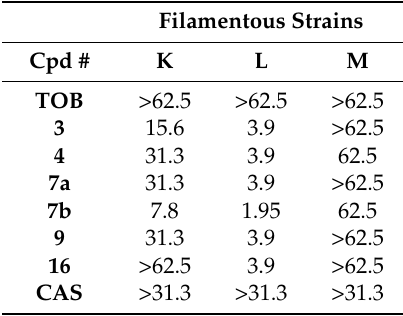
Table 3. The MIC values a (in µ g/mL) determined for TOB; its derivatives 3 , 4 , 7a , 7b , 9 , and 16 ; as well as CAS, against a panel of three Aspergillus